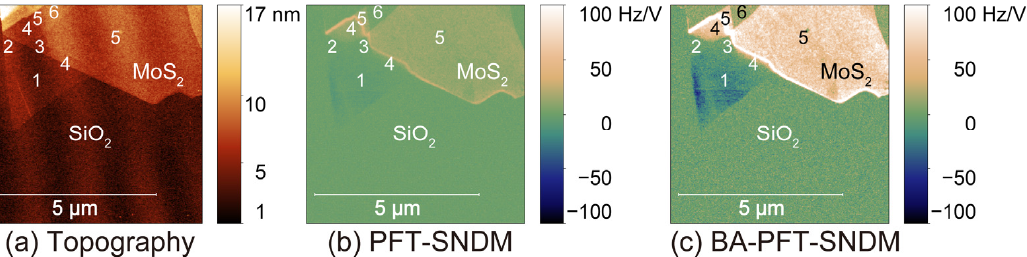
Figure 11. Topographic ( a ), PFT-SNDM ( b ), and BA-PFT-SNDM ( c ) images of atomically thin Nb-doped MoS 2 mechanically exfoliated on a thermally oxidized Si substrate. Each Arabic number in the figures denotes the number of stacking layers on the corresponding area.